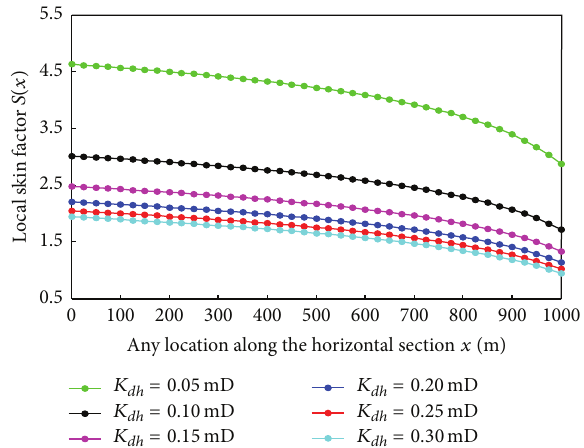
Figure 6: Effect of DZ’s permeability ( 𝐾 𝑑ℎ ) on skin factor ( 𝐿 = = 0.1 m, 𝜀 = 0.00016 m, 𝛾 = 0.56 , 𝜇 = 0.023 mPa ⋅ s, 1000 m, 𝑟 𝑤 𝑔 𝑔 = 20 MPa, 𝐾 = 0.6 mD, 𝑍 = 0.9 , 𝑇 = 366 K, ℎ = 10 m, 𝑝 𝑤𝑓 ℎ = 0.1 mD, 𝐾 = 1.2 mD, 𝑑 = 1.6 m, 𝑑 = 0.2 m, 𝐾 V 𝑎ℎ V . max V . min = 1.2 m, and 𝑎 = 0.15 m). 𝑎 V . max V . min